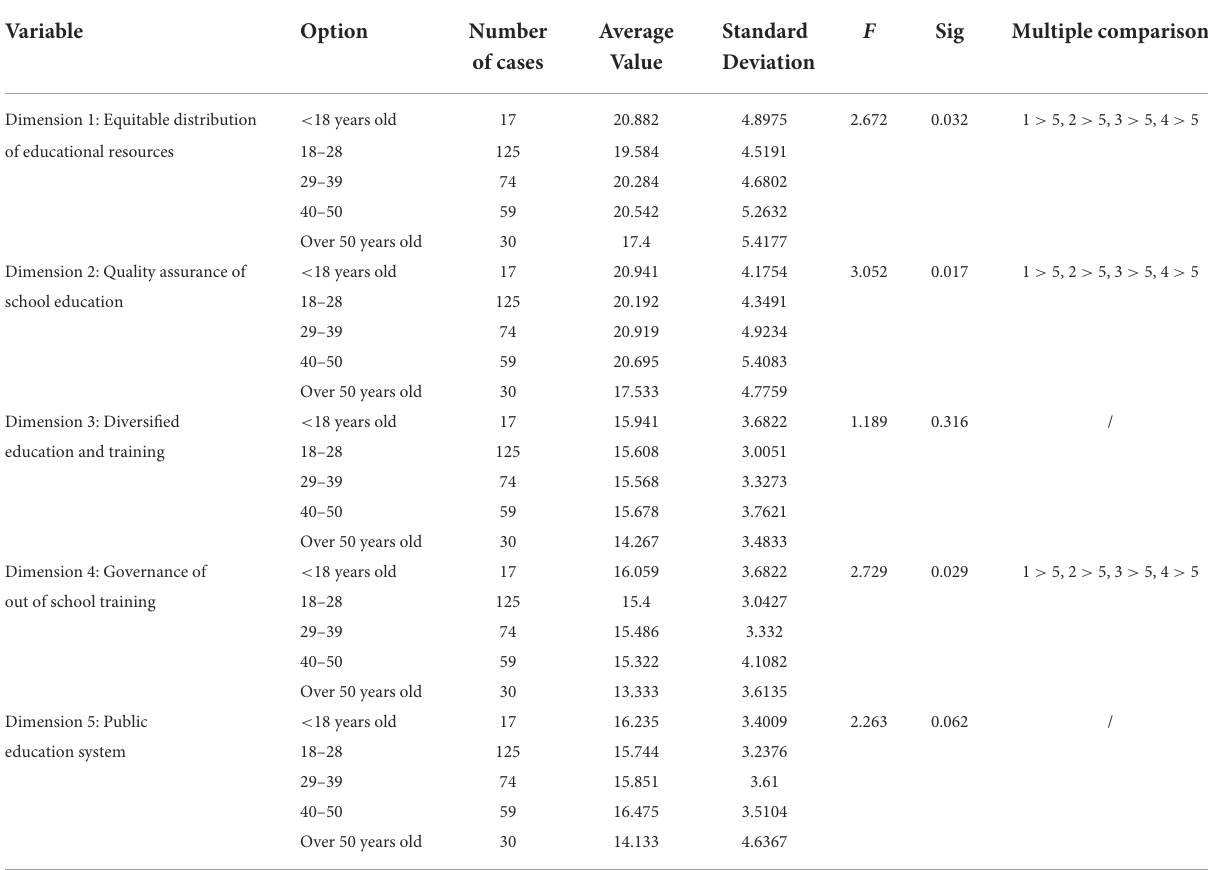
TABLE 10 Analysis of differences in age of each dimension